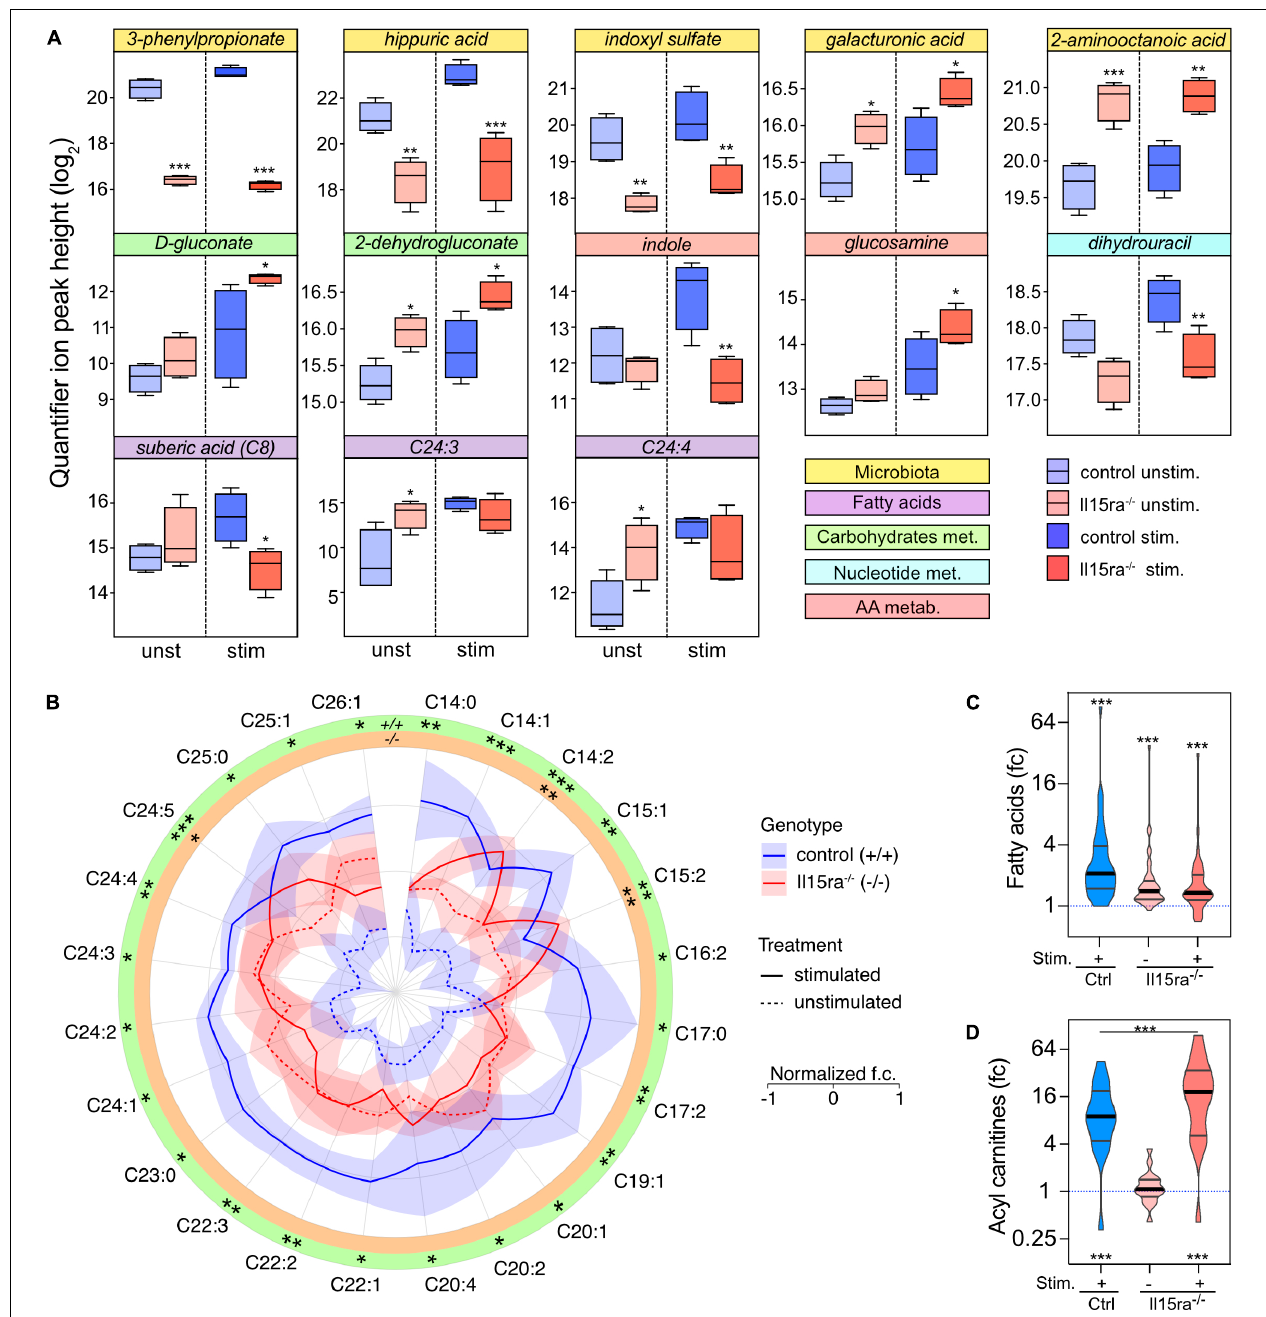
FIGURE 6 | Univariate analysis of the effect of genotype. (A) 2-way ANOVA with multiple comparisons of metabolites with significant interaction between stimulation and genotype. Data are represented as mean ± SEM. (B) Radar chart representation of the levels of fatty acids significantly mobilized upon stimulation in control (blue lines) and Il15ra − / − (red lines) EDL muscles. The fold changes of each fatty acid have been normalized (mean 0 and variance 1) for visualization purposes. Violin plots of mobilization of the total fatty acids (C) and carnitine (D) pools detected by the assay. In panels (C) and (D) , the dashed line represents controls unstimulated. Statistical significance was calculated vs. control unstimulated using one-way ANOVA on log 2 -transformed intensities before conversion to fold change. ∗ P < 0.05, ∗∗ P < 0.01, and ∗∗∗ P <